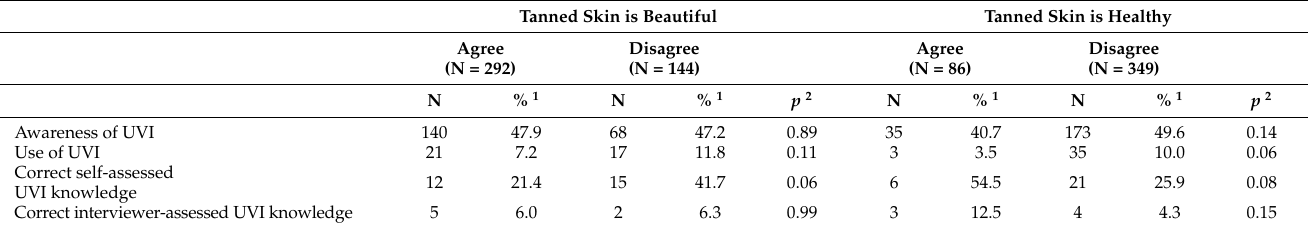
Table 5. The relationship between awareness, use and knowledge of the UVI and attitudes to- wards tanned skin based on answers of directors of kindergartens (N = 436). Absolute frequencies (N), proportions (%) and p -values ( p ) assessing the association between UVI-related variables and attitude